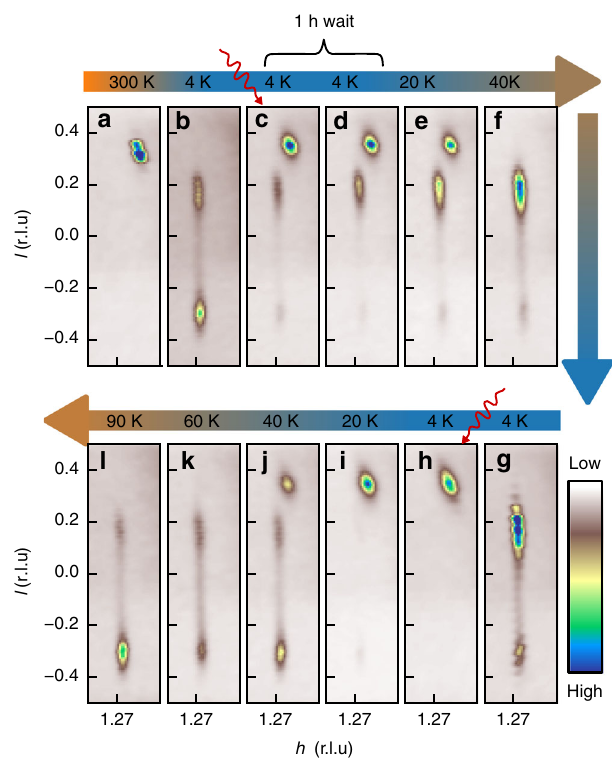
Fig. 3 Thermally driven HCDW-CCDW transition for two successive laser pulse/heating cycles. a The NCCDW superstructure peak at room temperature. b The diffuse CCDW double peak at 4 K. c The peak l -pro fi le after the fi rst photoexcitation at 3 K. Coexistence of CCDW peak and HCDW peak indicating only partial switching. d Same as c after waiting for 1 h, demonstrating the persistence of the HCDW. e , f Peak l -pro fi les for heating up to 40 K where the HCDW peak vanishes. g CCDW peak l -pro fi le after cooling to 4 K again. h Peak l -pro fi le of the HCDW after a second laser pulse with higher fl uence resulting in a more complete switching. i – l Second warming cycle up to 90 K. The CCDW peaks reappear at around 40 K, in j